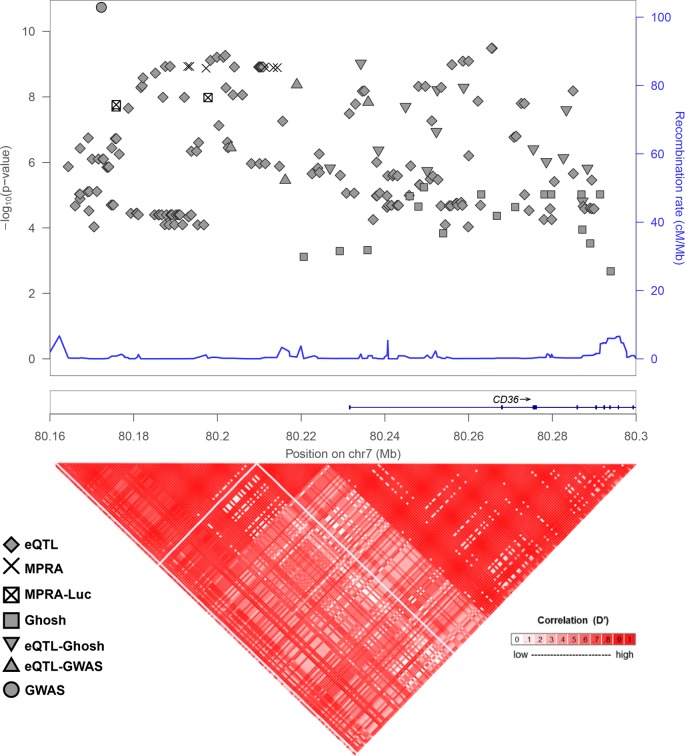
Genomic context of CD36 variants.(Upper) Manhattan plot of CD36 variants identified as platelet eQTLs only (diamonds), associated with CD36 surface levels (squares), GWAS-implicated (circle), eQTLs and CD36 surface level associated (upside down triangle), eQTLs and associated with GWAS-implicated (triangle), eQTLs and functional in MPRA assay (X’s), or eQTLs functional in MPRA assay and validated by luciferase (squared X).–log10 P-values are significance of eQTL association, if available, or from CD36 surface level association. GWAS-implicated variant (circle) is associated with platelet count (P = 2 x 10−17) and vertical position does not represent significance. (Lower) LD-plot of genomic locus with D’ values calculated with 1000 genomes JPT (Japanese) population.